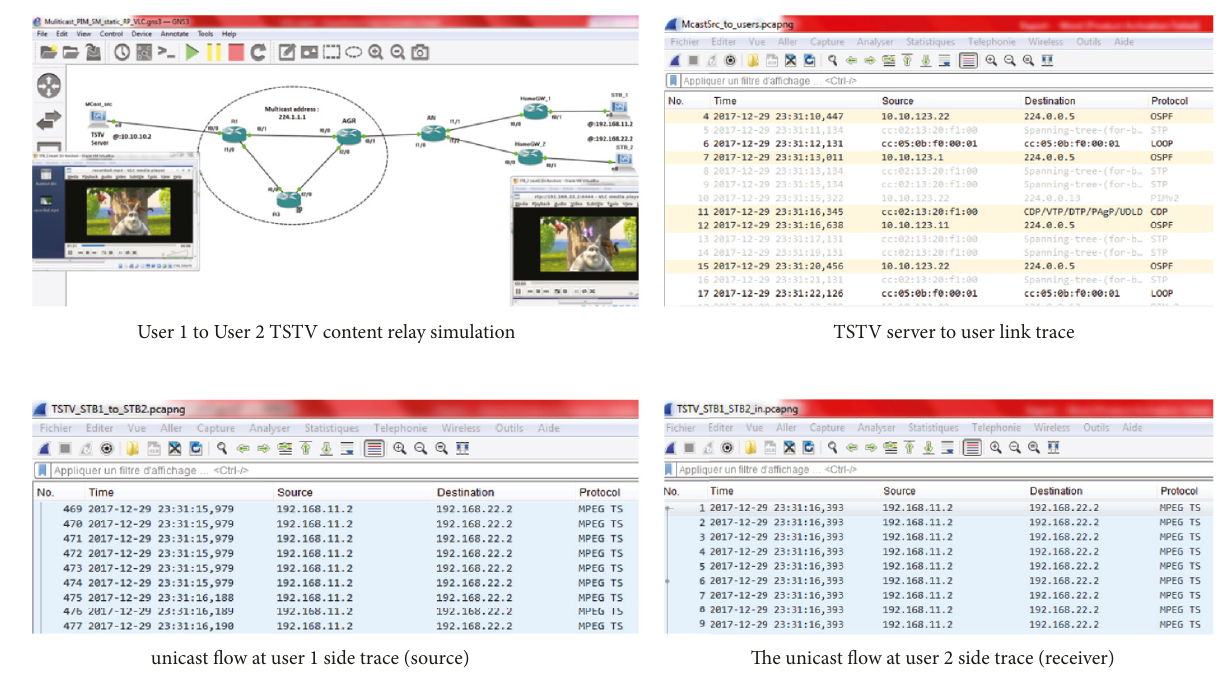
Figure 15: User 1 to user 2 TSTV content relay simulation results.